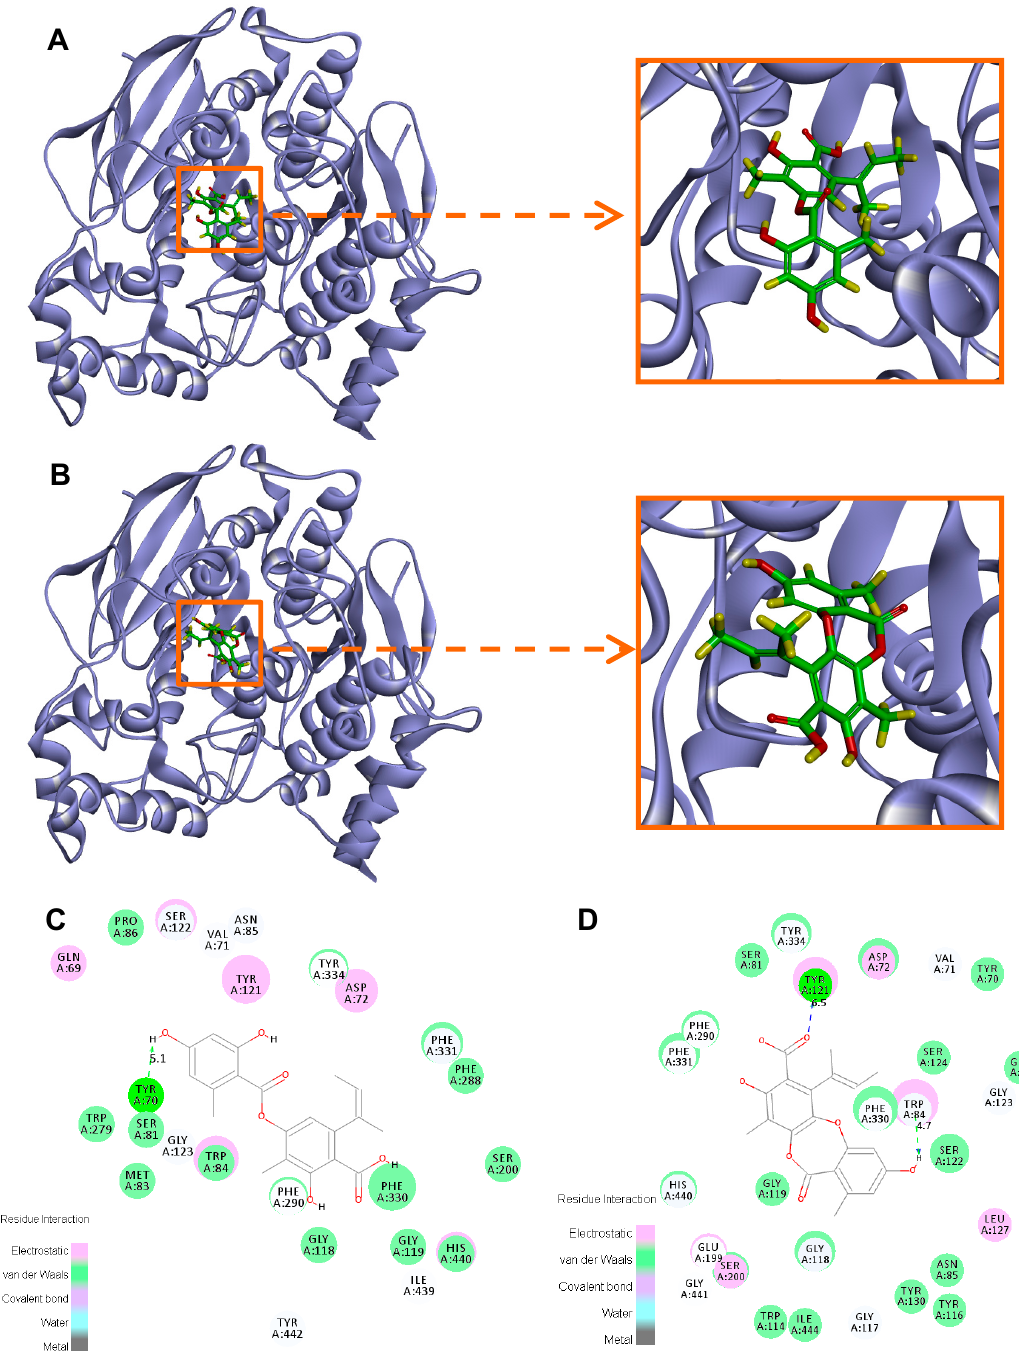
Figure 5. Representation of the binding mode of compounds 1 ( A , C ) and 9 ( B , D ) in the active site of AChE.